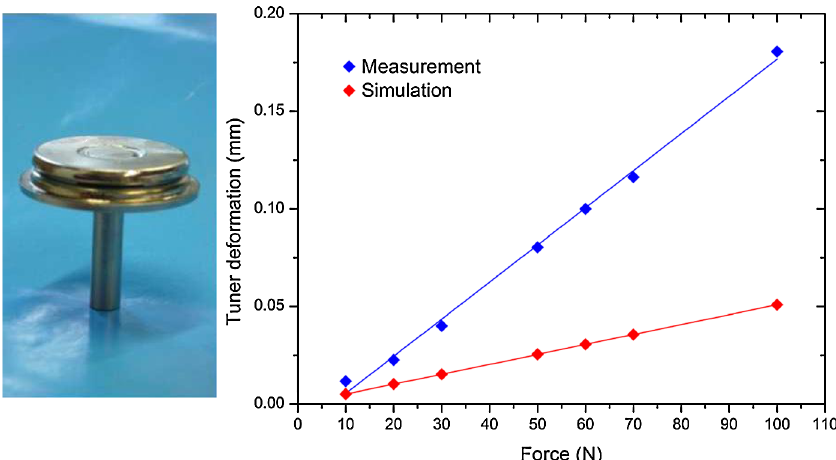
FIG. 7. (Color) Bellow tuner prototype of niobium with one and a half segments (left) and related results from measurements at room temperature in comparison to the simulations (right).